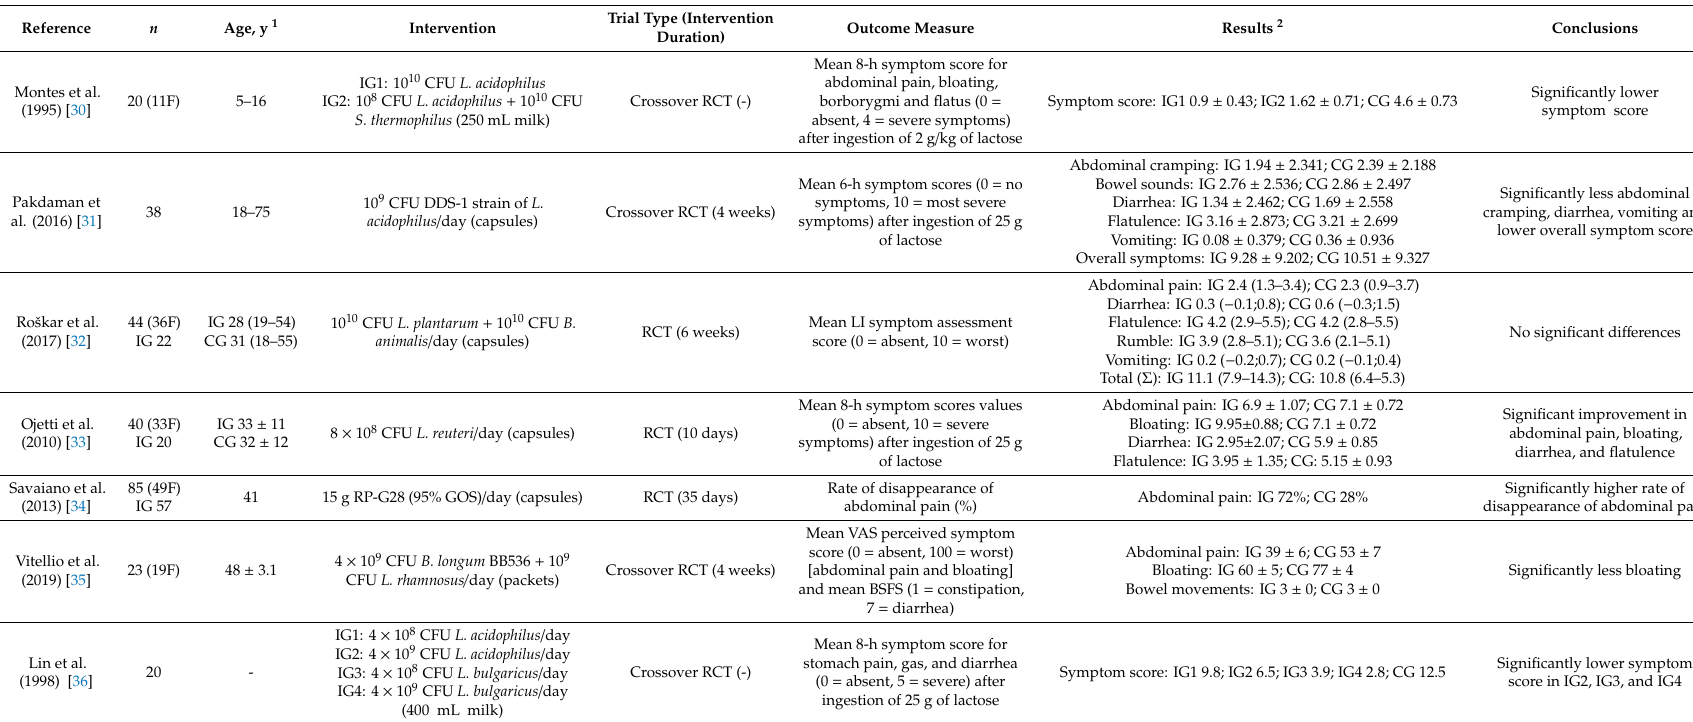
Table 2. E ff ects of prebiotics and probiotics on symptoms of lactose intolerance in 170 individuals with lactose malabsorption in controlled